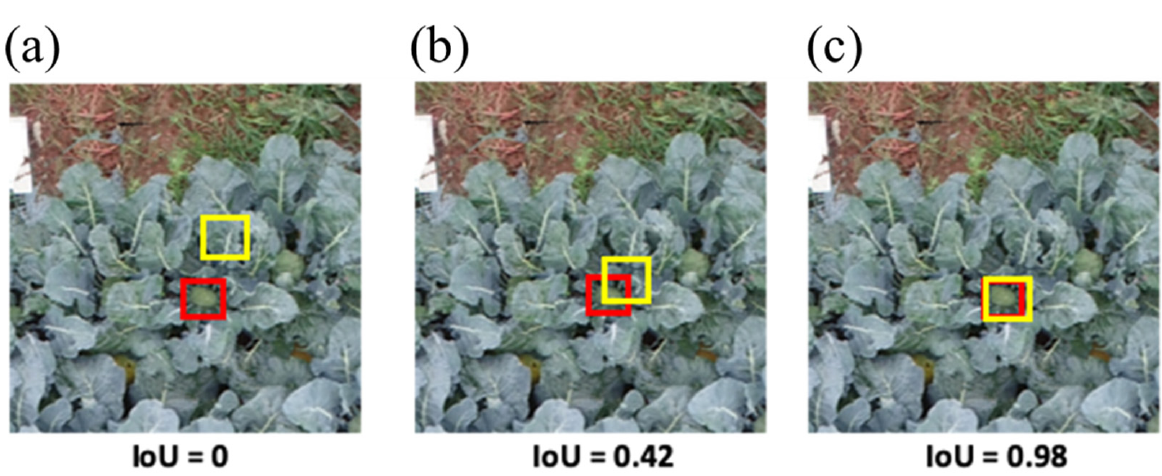
Figure 8. The ground truth (red box) and prediction (yellow box) determine the IoU score, which will be used to decide whether the prediction is correct or not. ( a ) Ground truth and predicted bounding box with IoU of 0; ( b ) ground truth and predicted bounding box with IoU of 0.42; and ( c ) ground truth and predicted bounding box with IoU of